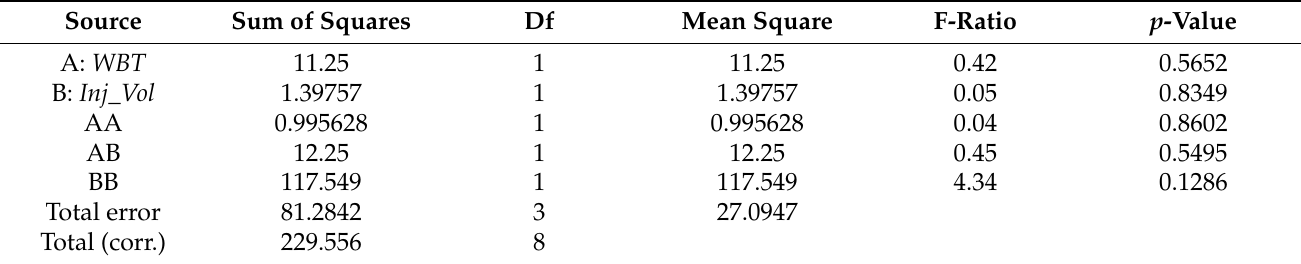
Table 7. Analysis of Variance for the restart time of the instantaneous